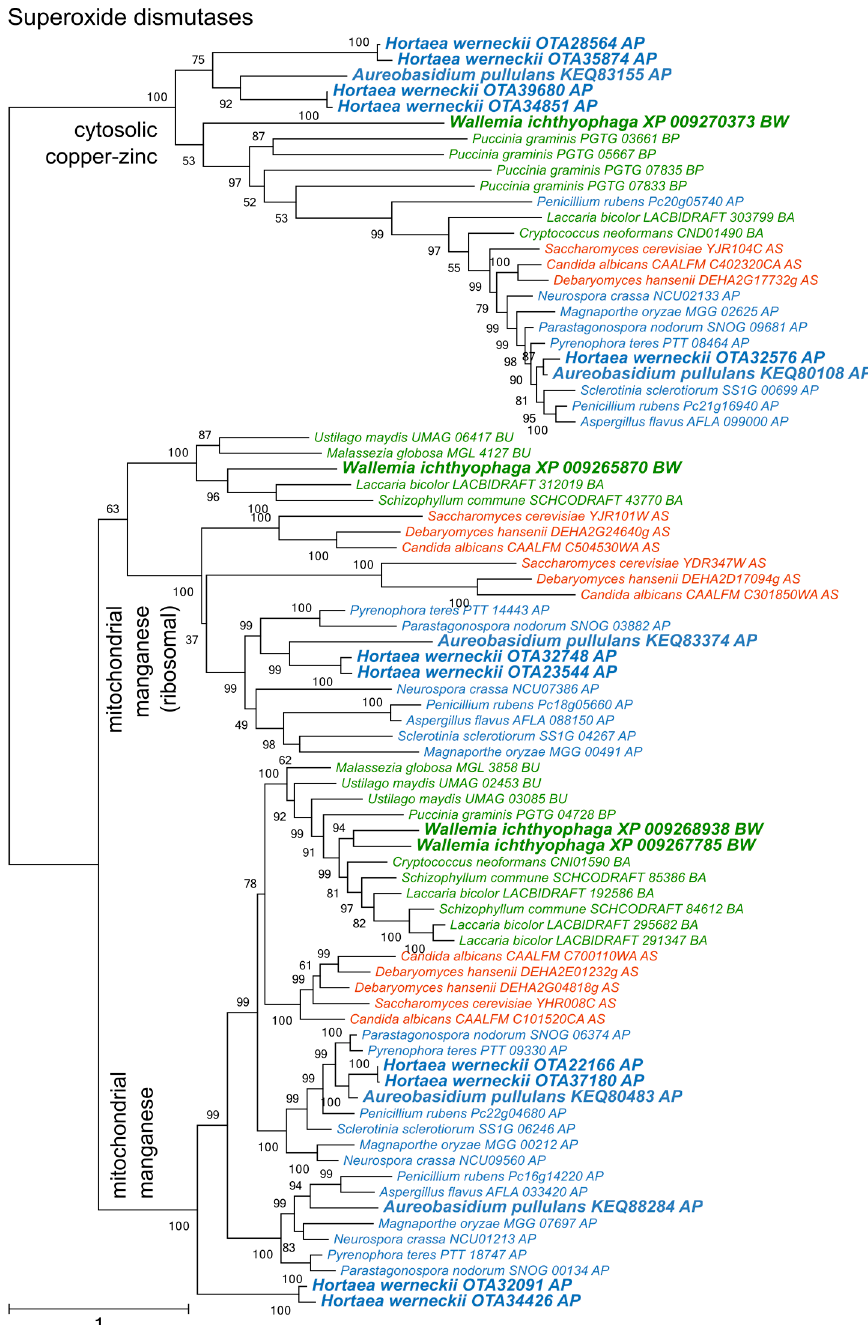
Figure 2. Maximum likelihood phylogeny of genes encoding superoxide dismutases. The phylogeny was estimated by PhyML software with approximate likelihood-ratio test (aLRT) implementation